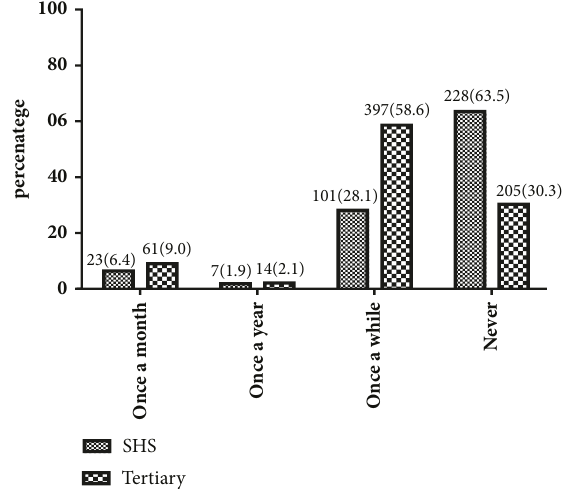
Figure 1: Frequency of BSE performance among study participants.